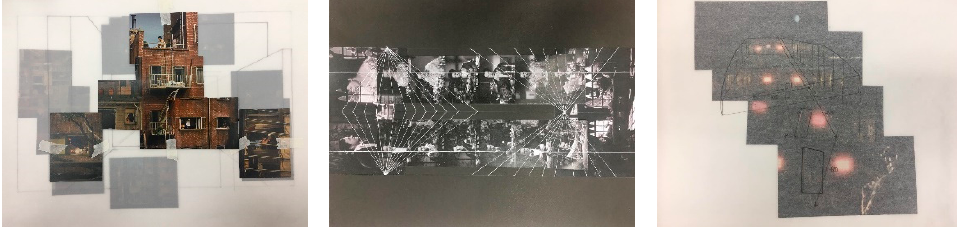
Figure 5. Various synthetic drawings of students’ designs.